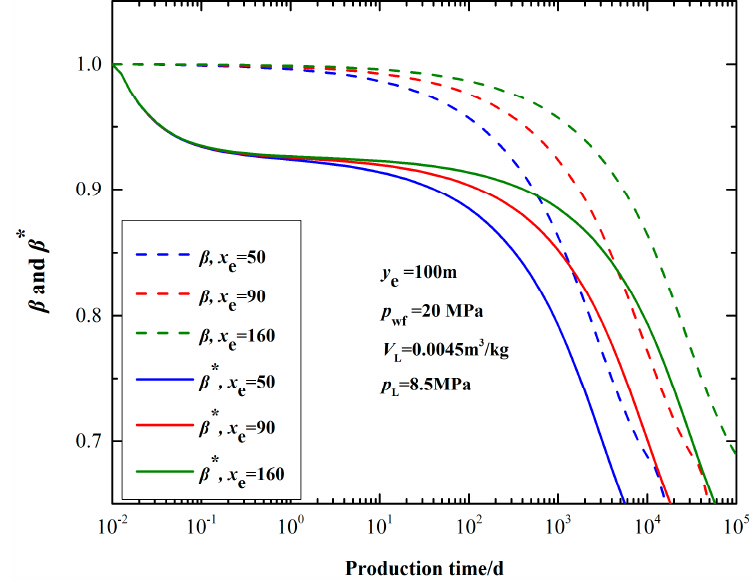
Figure 2. Change relationship of β ( t ) and β *( t ) over time.